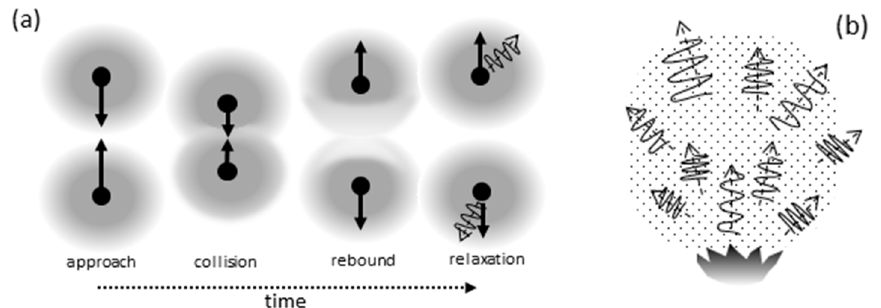
Figure 2. Schematics of inelastic collisions in a gas of finite-size atoms: ( a ) progression of an inelastic collision (viewed in the center of mass reference frame) with time. Black = nuclei. Grey = shells of electrons, forming a shielding cloud, which deforms during the collision, thereby consuming some of the energy of the collision. Squiggle arrow = thermal photon, emitted as the electron cloud adjusts to the reduction in force. Hence, each collision results in a tiny reduction in the thermal energy of the gas; ( b ) steady-state conditions in a body of gas. Applied heat (the fire) establishes T and a distribution of molecular velocities. The velocity distribution produces a thermal photon gas with its energy distribution linked to the velocities. Thermal photons escape, providing blackbody emissions, with this same distribution. To maintain constant T of the substance, heat must be continually supplied. Thus, isothermal conditions require that the heat input = heat output with a negligible thermal gradient. Reprinted from Figure 5.2 a,d of Reference [33], with permission from Elsevier.